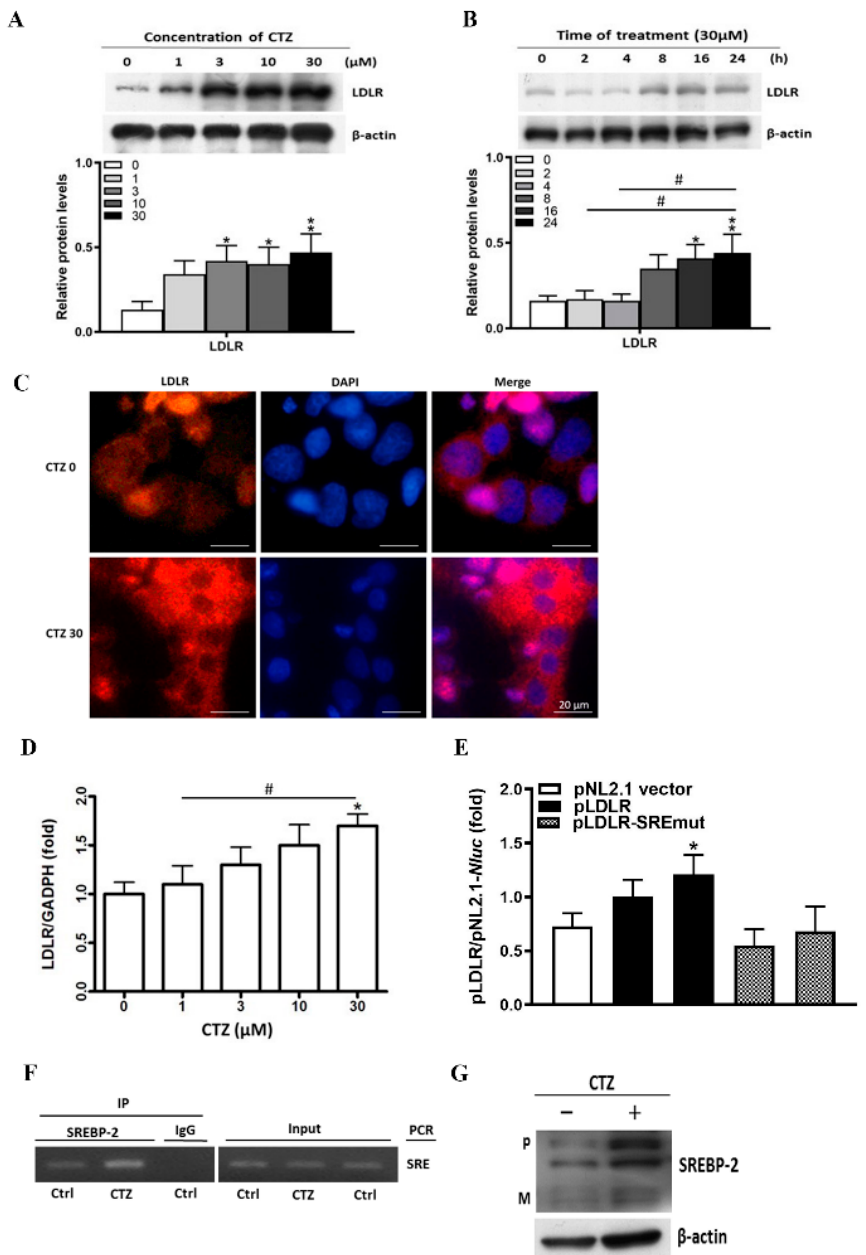
Figure 2. Cilostazol activates low-density lipoprotein receptor (LDLR) expression in HepG2 cells. * p < 0.05, and ** p < 0.01 versus the untreated group. # p < 0.05, comparison between treated groups. ( A ) HepG2 cells in serum-free medium were treated with cilostazol at different concentrations overnight (0, 1, 3, 10, 30 µ M). Protein levels of LDLR in HepG2 were measured by Western blotting. β -actin was used as a loading control. Quantification of blot intensity relative to loading control is shown below. ( B ) HepG2 cells in serum-free medium were treated with cilostazol (30 µ M), and then incubated for 0 min, 2 h, 4 h, 8 h, 16 h, and 24 h. Quantification of blot intensity relative to loading control is shown below. ( C ) Representative images of immunofluorescence staining with LDLR (red), 4 (cid:48) ,6-diamidino-2-phenylindole (DAPI) (nucleus, blue), and their colocalization (merge). Scale bar = 20 µ M. ( D ) Quantification of LDLR mRNA expression in the cilostazol-treated groups. The total cellular RNA was used to determine LDLR mRNA expression by Cell-RNA-cDNA real- time PCR. The results are represented as the mean ± S.E.M. from three independent experiments. ( E ) LDLR promoter was conducted with the mutation of SRE (pLDLR-SREmut). Expression vector